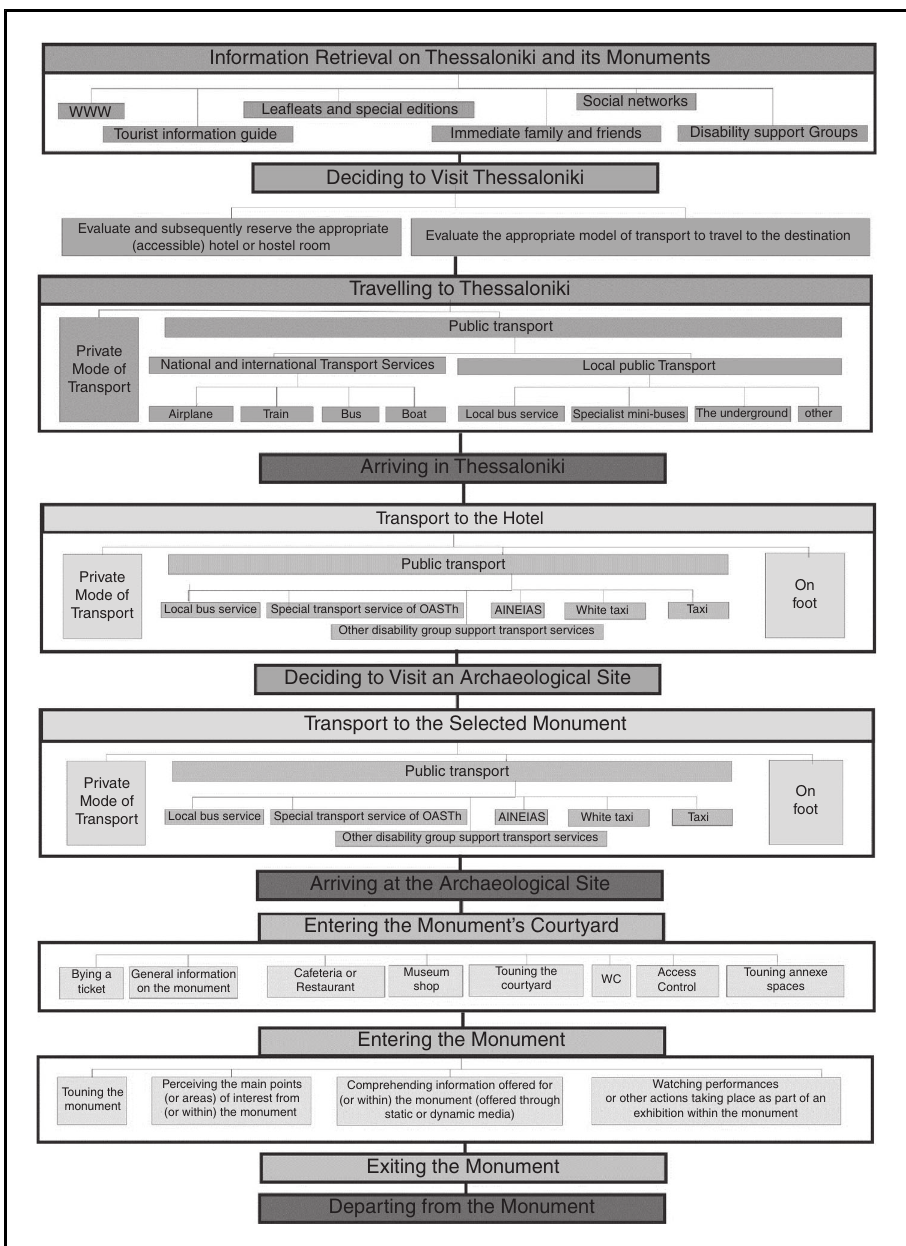
Figure 2 Task model of monuments ’